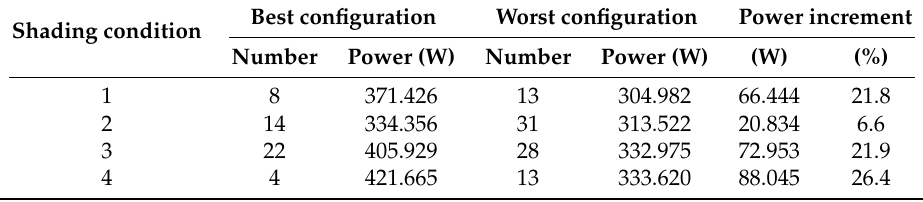
Table 1. Information of the best and worst configuration of the PV array for each shading condition.